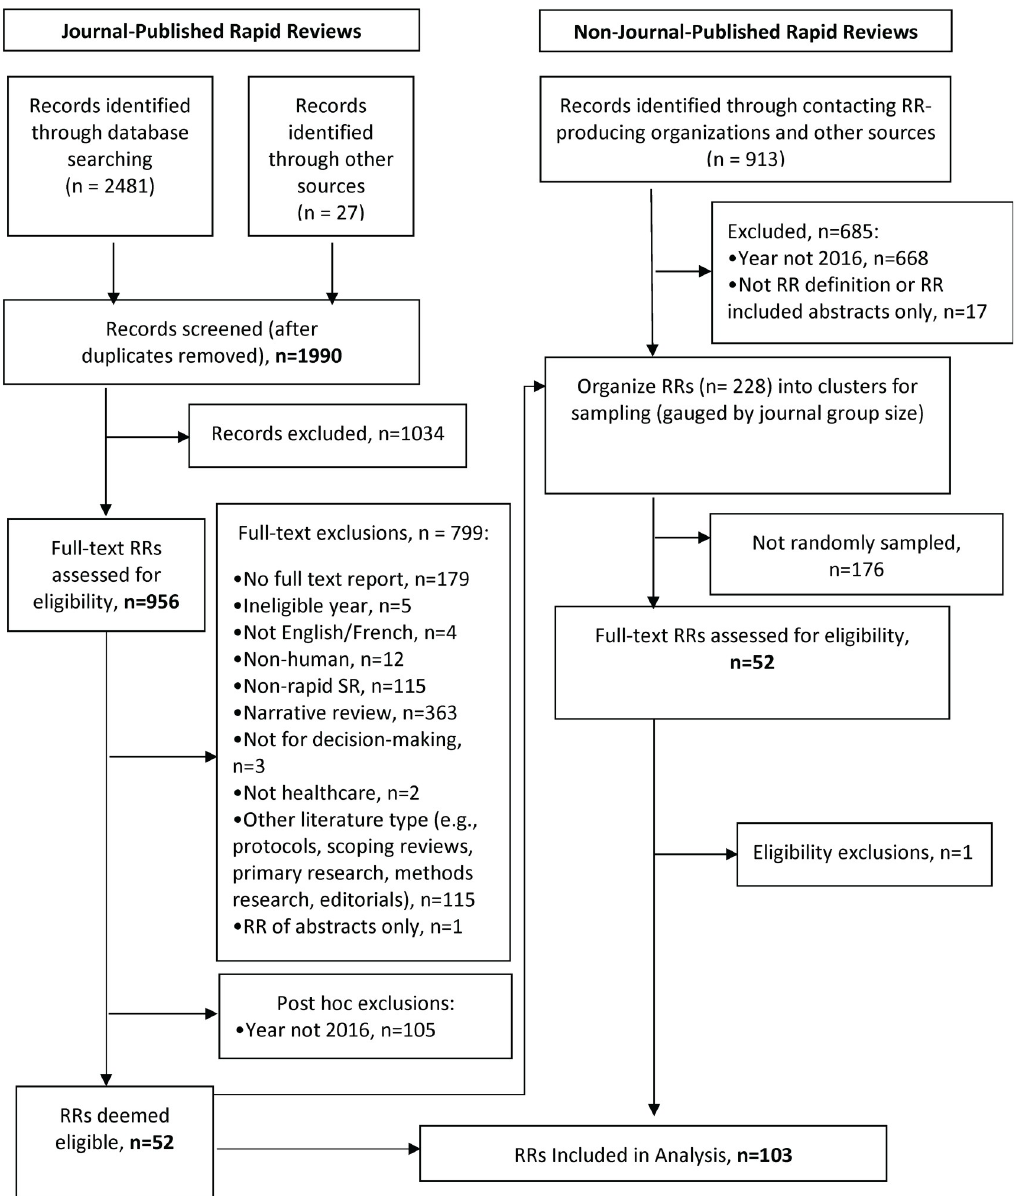
Fig 1. Study flow diagram. Breakdown of the number of rapid review reports identified, assessed for eligibly, and finally included in the main